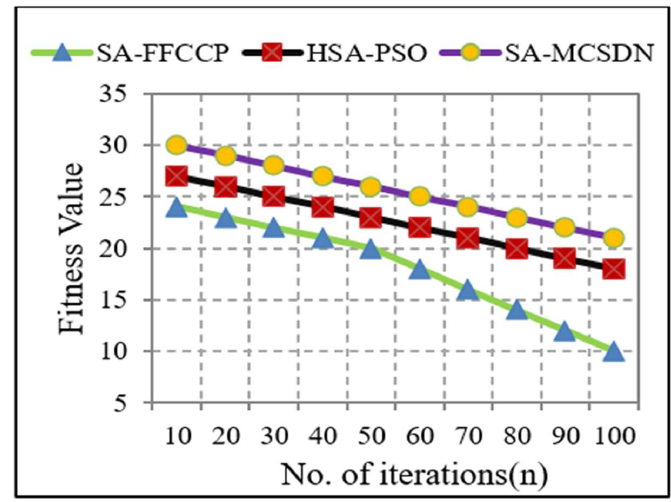
Figure 13. Comparison of fitness values.